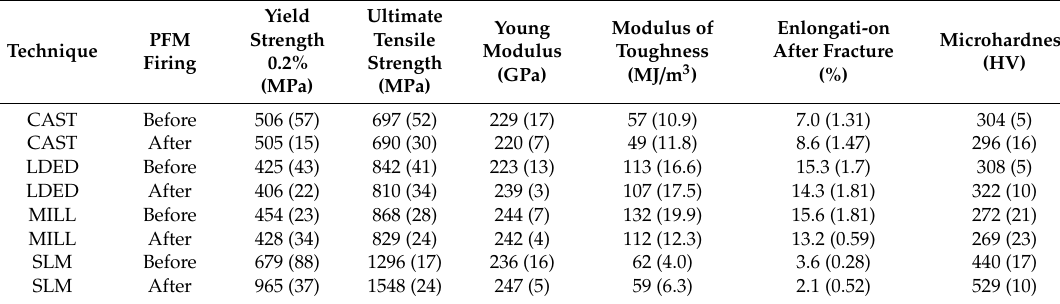
Figure 6. Representative stress–strain curves of the tensile tests among di ff erent techniques before PFM firing. Table 5. Numerical results of mechanical properties of the di ff erent techniques evaluated before and after PFM firing simulation. Standard deviation (SD) in